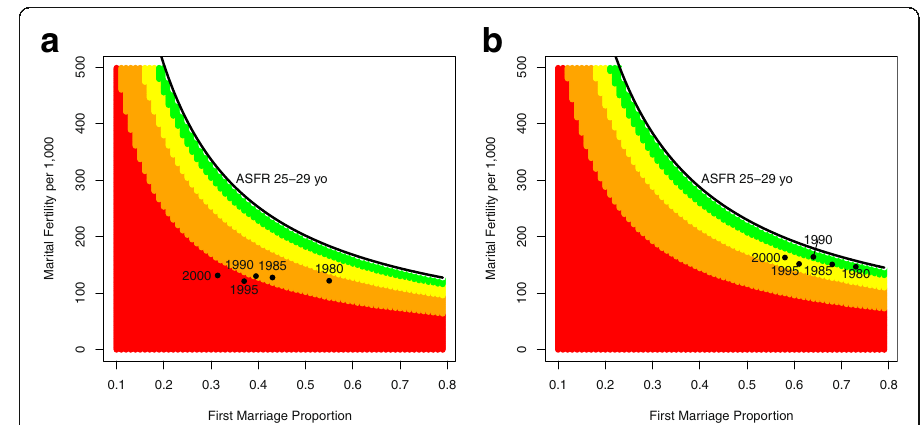
Fig. 4 Plots of marital fertility vs. proportion of women that have had a first marriage in the 25 – 29 year age range with colored regions indicating the ranges for the marital birth ratio. Points indicate the combinations of marital fertility and proportion married by year. Plot a indicates African- Americans and b indicates White Americans. Age-specific fertility rates assumed for a and b are 102 per 1000 women and 115 per 1000 women respectively. The colors represent marital birth ratios of green (greater than 90%), yellow (75 – 90%), orange (50 – 75%), and red (less than 50%). Data from (Ventura and Bachrach (2000); Martin et al. (2002); National Center for Health Statistics (NCHS) (2006); Martin et al.